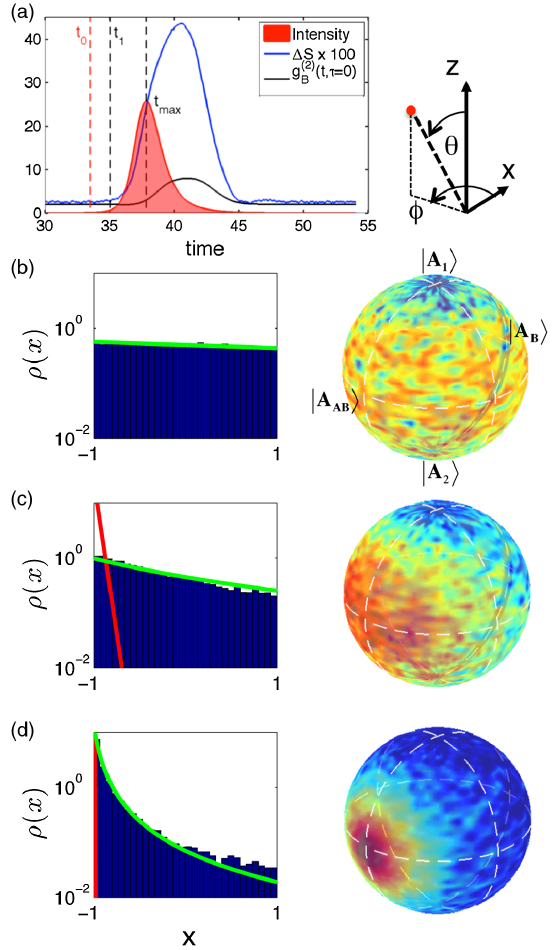
FIG. 1. Numerically simulated response of a coupled nanolaser 32 ). system under short-pulse pumping (centered at t pump ¼ (a) Evolution of total laser output intensity (red), excess entropy (blue), and second-order autocorrelation for the bonding mode (black). (b) – (d) Snapshots of the PDFs for the fractional population imbalance (left) and Bloch sphere representations (right) at (b) t ¼ 20 (before laser buildup), (c) t 1 ¼ 35 (during the 37 . 8 (pulse maximum). Red early phase buildup), and (d) t max ¼ curves on PDFs represent the equilibrium solutions of Eq. (7) to a final temperature as given by the instantaneous intensity. Green curves are T ¼ 0 , “ free-falling ” approximations of the PDF [Eq. (9)] with fitted t 0 ¼ 33 . 5 . The simulation parameters are 28 K ¼ 7 , γ ¼ − 0 . 1 , α ¼ 5 , P ¼ 4 P , and γ − 1 th tot ¼